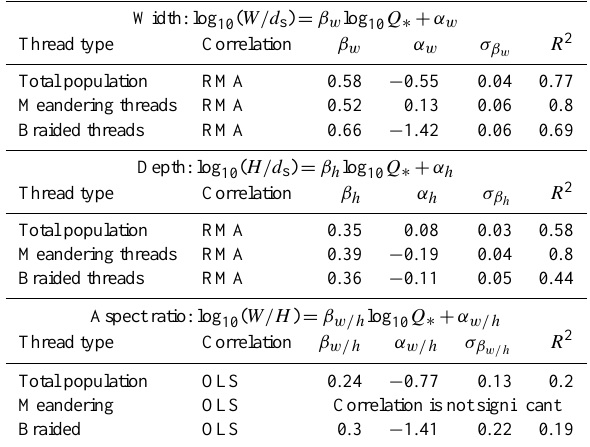
Table 1. Linear regressions on the log 10 of width, depth and aspect ratios of threads as functions of discharge. The confidence level is 95%. RMA: reduced major axis regression; OLS: ordinary least square. σ β stands for confidence interval on the slope of the regres- sion β